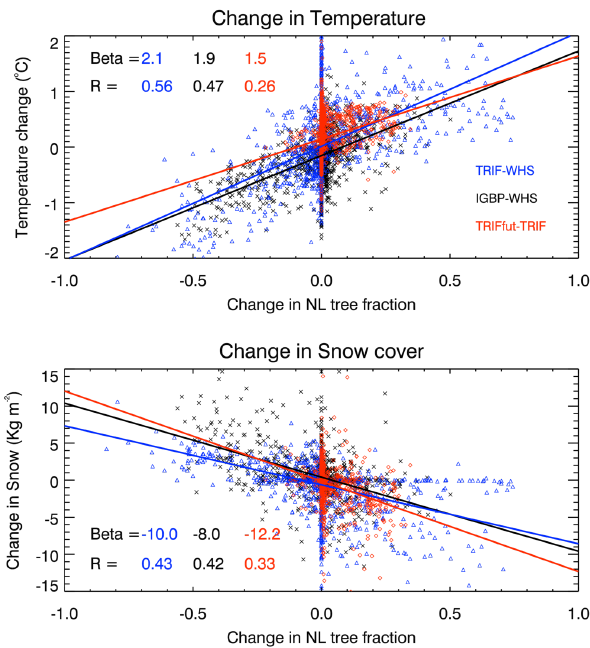
Fig. 4. Change in gridcell annual mean (top panel) temperature and (bottom panel snow cover against change in needleleaf (NL) tree cover in the grid box for (black) IGBP – WHS, (blue) TRIF – WHS, and (red) TRIFfut –TRIF. Values for the slope (Beta) and correlation coefficient ( R ) are given in each case.